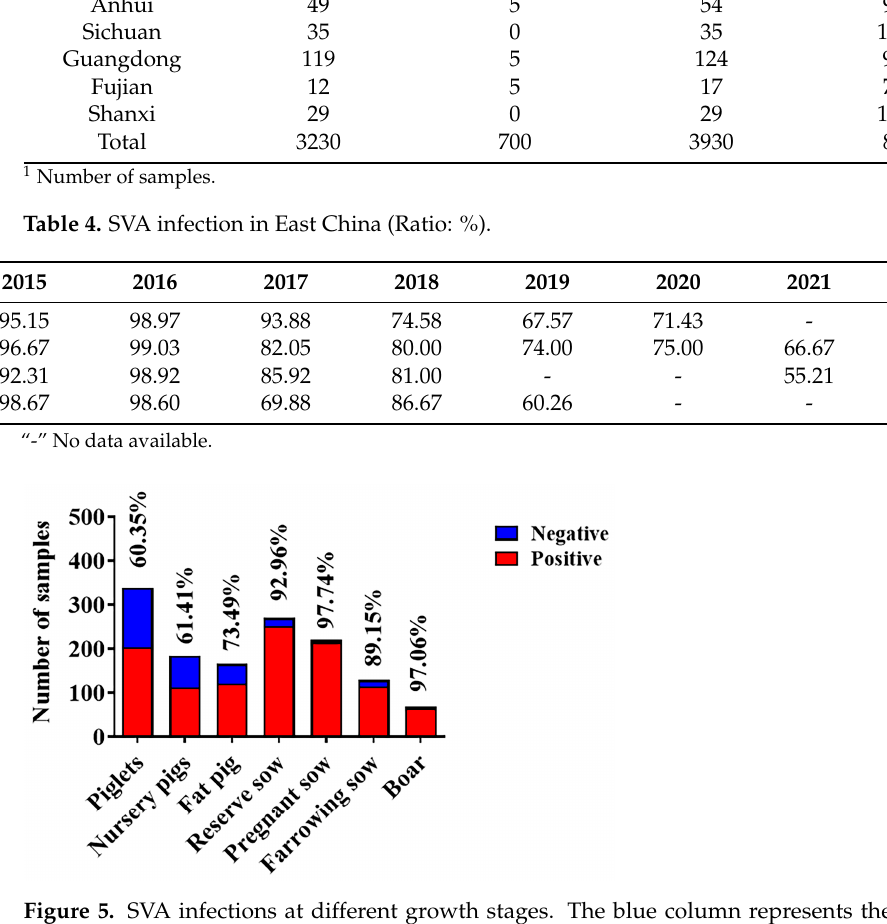
Figure 5. SVA infections at different growth stages. The blue column represents the amount of neg- negative serum and the red column represents the amount of positive ative serum and the red column represents the amount of positive serum.